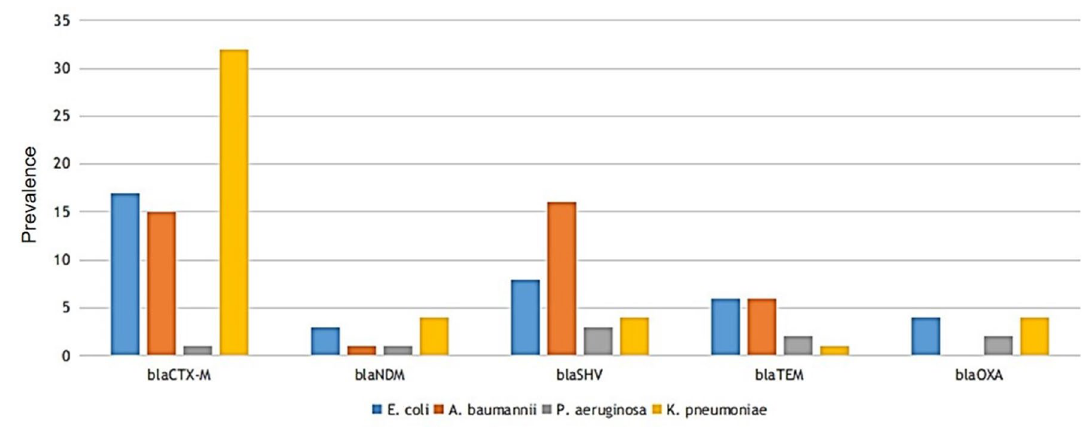
Figure 2. Isolates-wise prevalence and distribution of carbapenemase genes in Gram-negative bacteria.